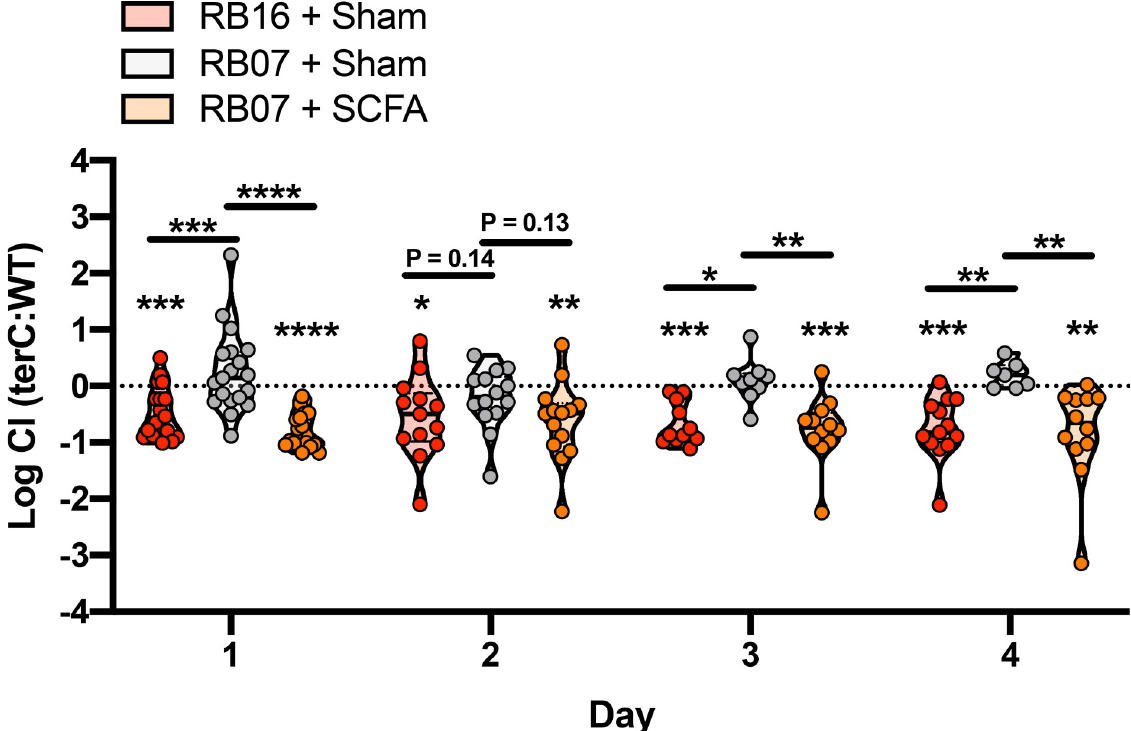
Fig 5. Exogenous treatment of mice with SCFAs results in a terC fitness defect. Seven days prior to inoculation, male and female C57BL6/J mice sourced from barriers RB16 and RB07 were treated with a SCFA cocktail or regular drinking water (sham). NTUH-K2044 and the isogenic Δ terC mutant (clone Kp2257) were mixed 1:1 and approximately 5x10 6 CFU were orally gavaged into mice (n = 19 per group). A fresh fecal pellet was collected daily from each animal, CFUs were enumerated, and log competitive indices (mutant:WT) were calculated (median and IQR displayed, � P < 0.05, �� P < 0.005, ��� P < 0.0005, one-sample t test compared to a hypothetical value of 0 or Holm-Sidak multiple-comparison test following one-way ANOVA).